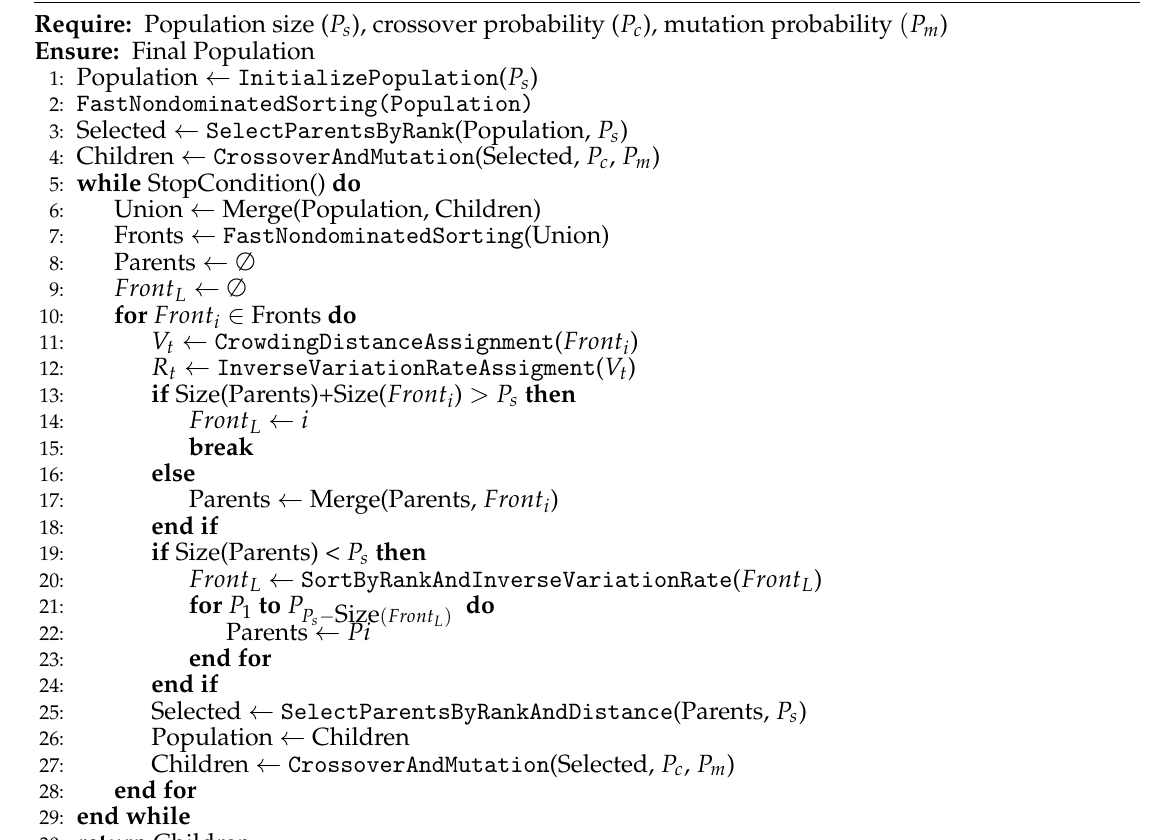
Algorithm A1 Pseudocode of